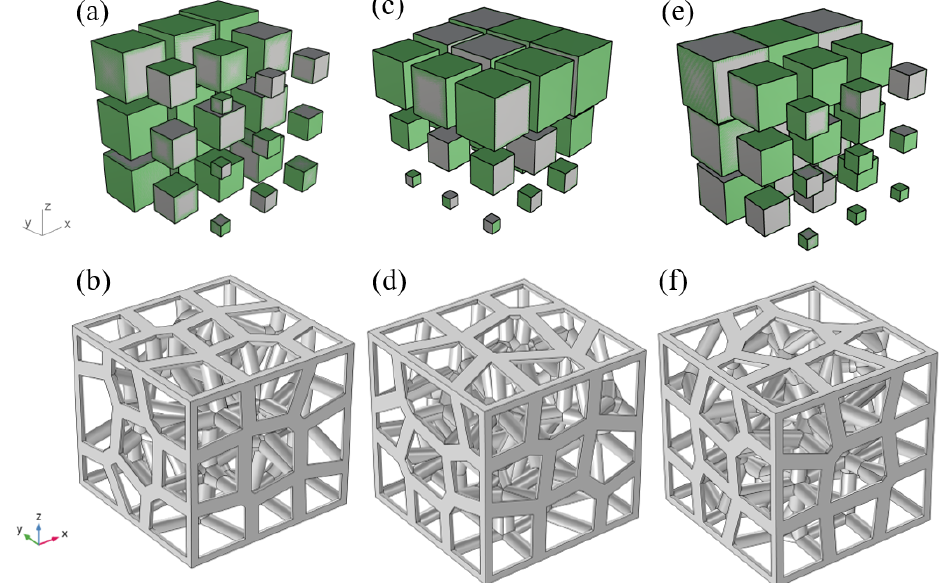
Figure 4. Gradient variation model of GV3 structure with 89.09 and porosity in OZ, OY,OX directions: ( a ) Gradient change in OZ direction; ( b ) OZ gradient structure; ( c ) Gradient change in OY direction; ( d ) OY gradient structure; ( e ) Gradient change in OX direction; ( f ) OX gradient